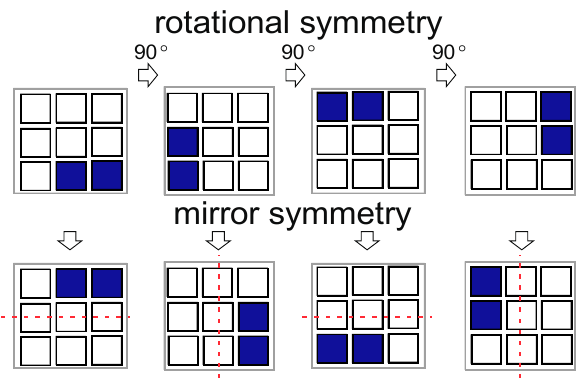
Figure 10. Mirror-rotation axial symmetry of the 4th order in class C 4 .